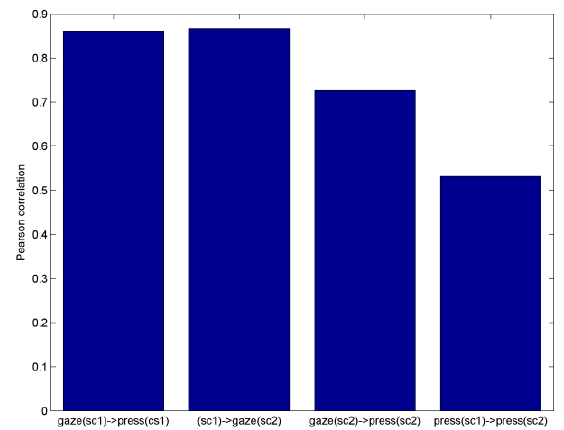
Figure 11. Even–odd reliability for different gaze-tracking-related in-game Figure 11. Even – odd reliability for different gaze-tracking-related in-game tasks.